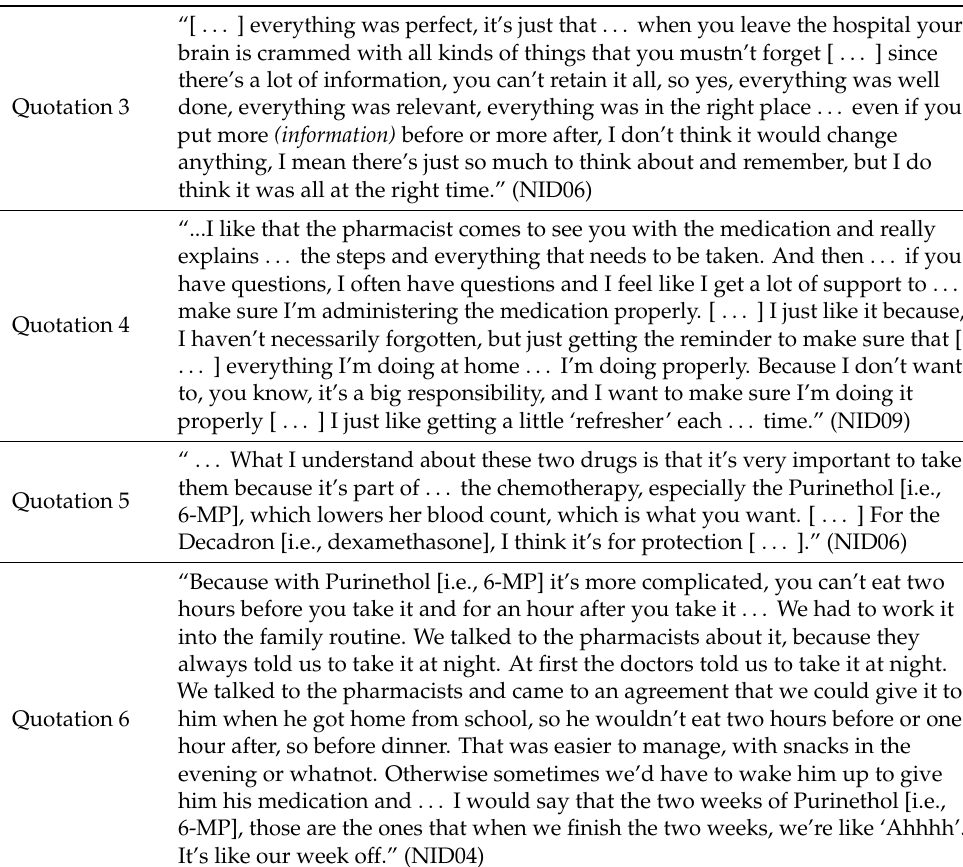
Table 3. Exemplar quotations from interviewed parents for the theme: Parents’ knowledge about oral